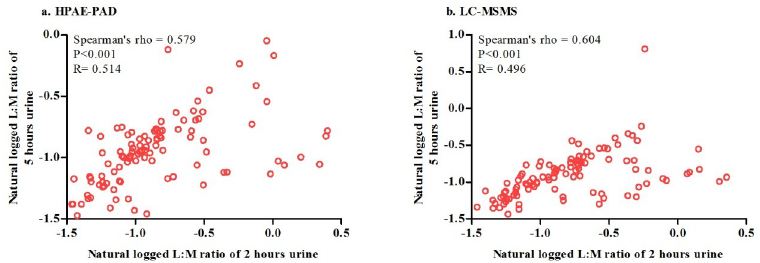
Fig 1. Correlations between standard 5 hours L:M ratio and shortened 2 hours L:M ratio. (a) HPAE-PAD and (b) LC-MSMS. (a) HPAE-PAD (n = 104); X axis indicates natural logged L:M ratio of 2 hours urine; Y axis stands for natural loged L:M ratio of 5 hours urine. (b) LC-MSMS (n = 104); X axis indicates natural logged L:M ratio of 2 hours urine; Y axis denotes natural loged L:M ratio of 5 hours urine. R stands for linear reression value; Spearman’s rho stands for Spearman’s nonparametric